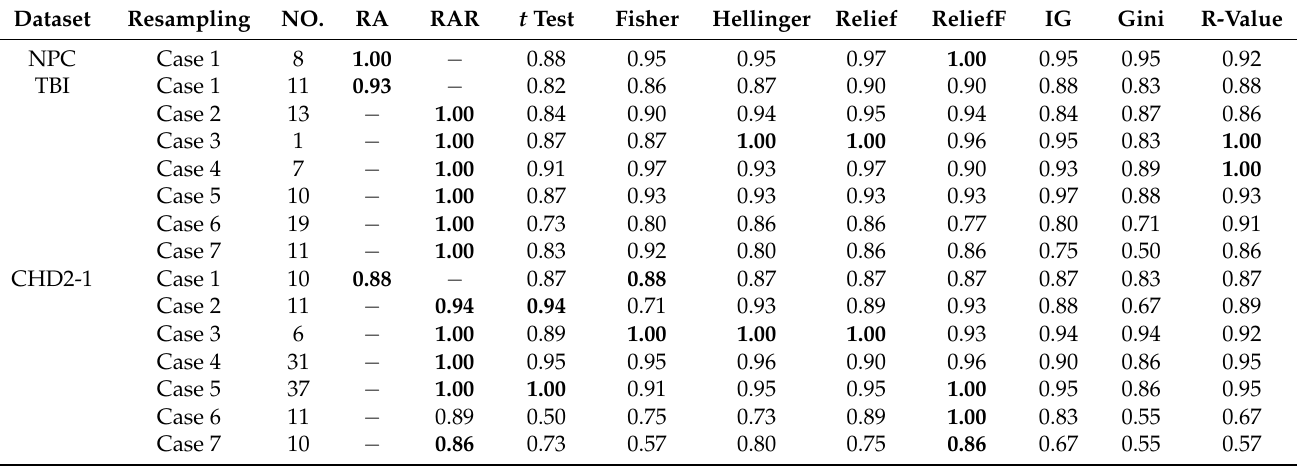
Table 2. F 1 from rank aggregation and eight filtering techniques (The best result is in